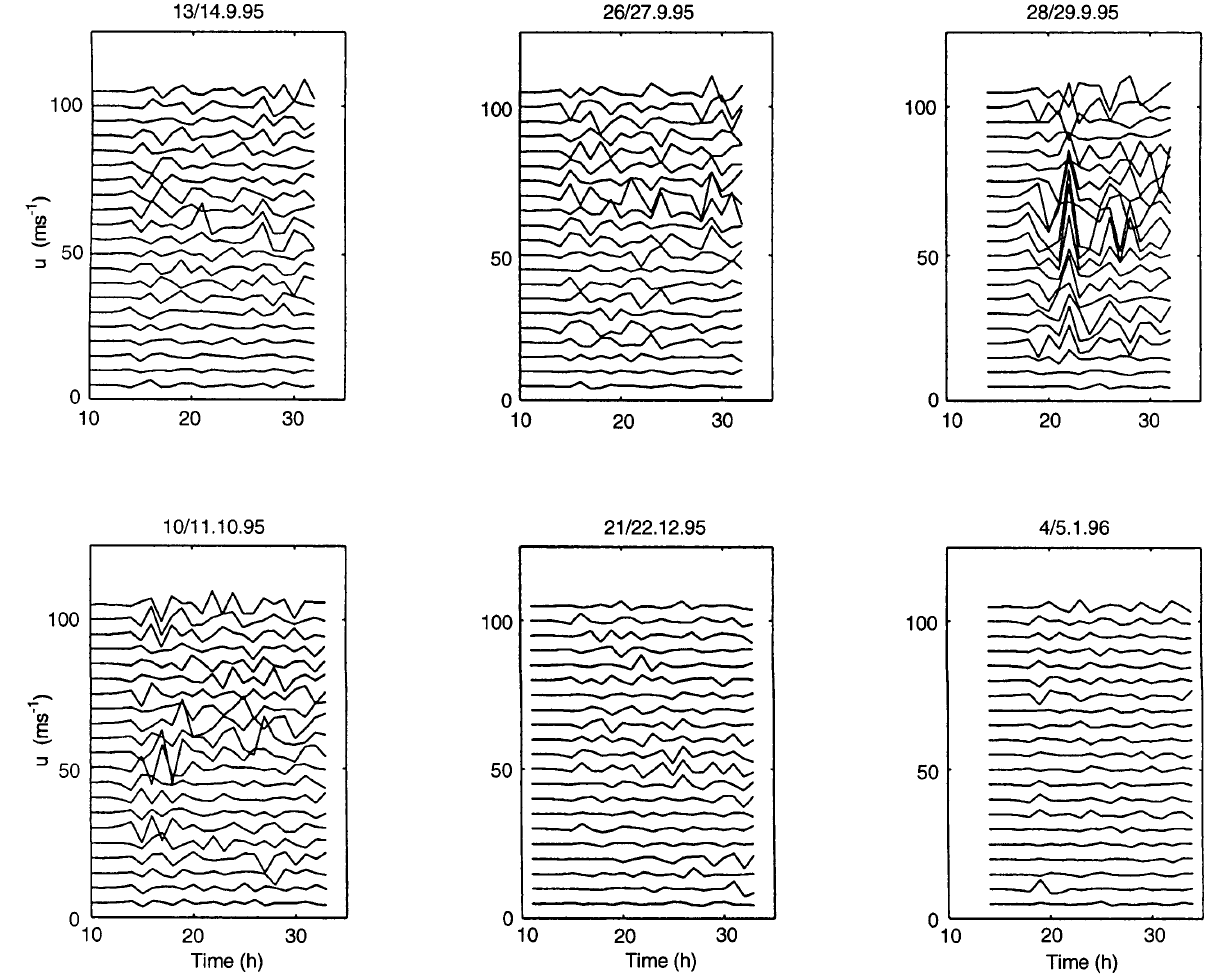
Fig. 3. Temporal variations of zonal winds at 21 heights between 6 and 21 km. Successive plots are displaced by 5 ms )